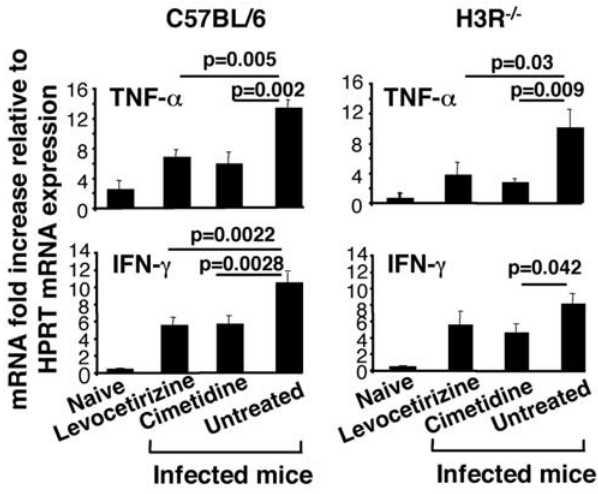
Figure 9. Down-regulation of inflammatory response-associat- ed genes by histamine receptor antagonists. Wild-type C57BL/6 and H3R 2 / 2 mice were treated or not with H1R inhibitor (Levocetirizine) or H2R inhibitor (Cimetidine) one day before and throughout the infection period by inoculating 10 6 Pb ANKA-infected erythrocytes. Six days post-infection, brains were analyzed for the expression of TNF- a and IFN- c as measured by quantitative RT-PCR. Gene mRNA expression is normalized relative to hypoxanthinephophoribosyltransferase. Data are presented as the means 6 SD from two independent experiments. Significant differences between groups indicated by presence of a bar over the respective columns were determined by Kruskal-Wallis test followed by Dunn’s Multiple Comparison